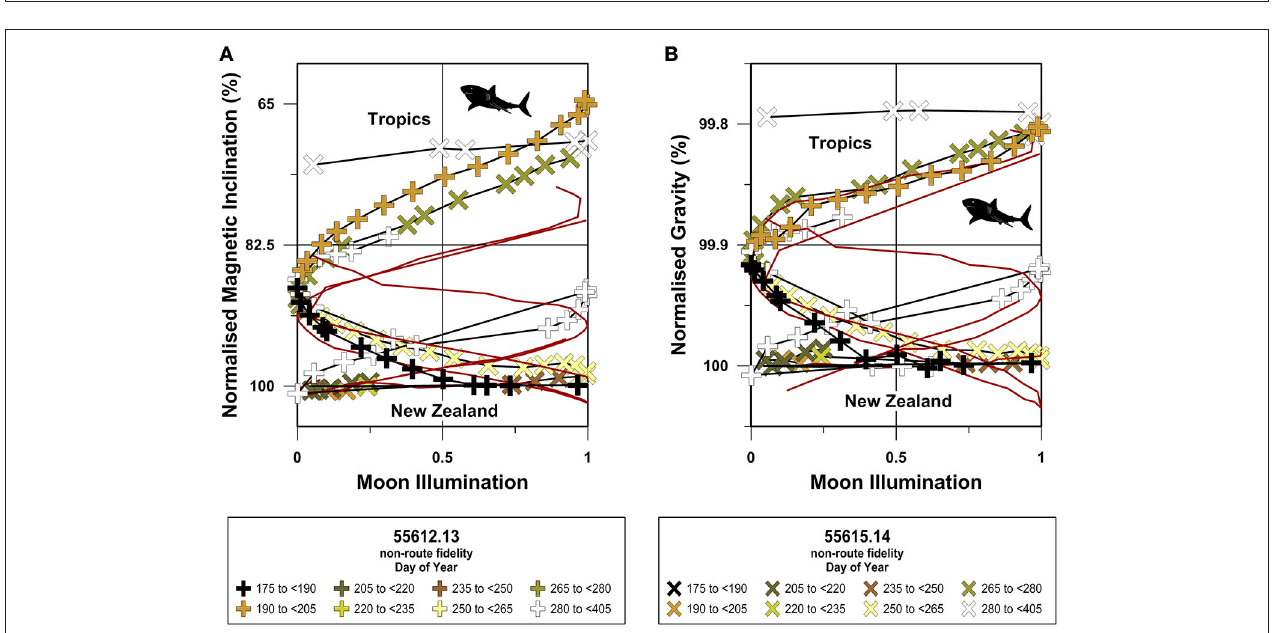
FIGURE 9 | Site-normalized South Pacific great white shark magnetic inclination and gravitational trajectories. In this figure geocentric magnetic inclination and latitude and bedrock dependent g L + g B values have been normalized to the values present at the locations inhabited immediately prior to the onset of long-distance open-ocean migration at the individual level. Site-normalized magnetic inclination (A) and gravitational acceleration (B) values are displayed as percentages and are plotted against the moon illumination cycle as in Figures 5 – 7 . Route fidelity movements are shown as dark red lines and non-route fidelity movements are symbolized as indicated in the figure legends. Non-route fidelity track symbol colors correspond with day of the year and exceed 365 days when the tracked movement spanned Julian calendar years.